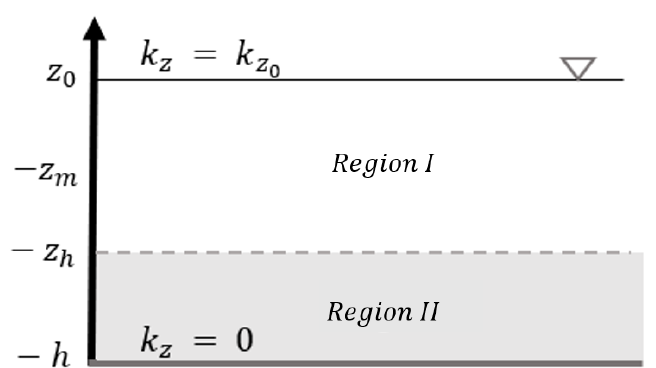
Figure 5. Distribution of the water column in Regions I and II to ensure the continuity of k z and determine the inflection point.